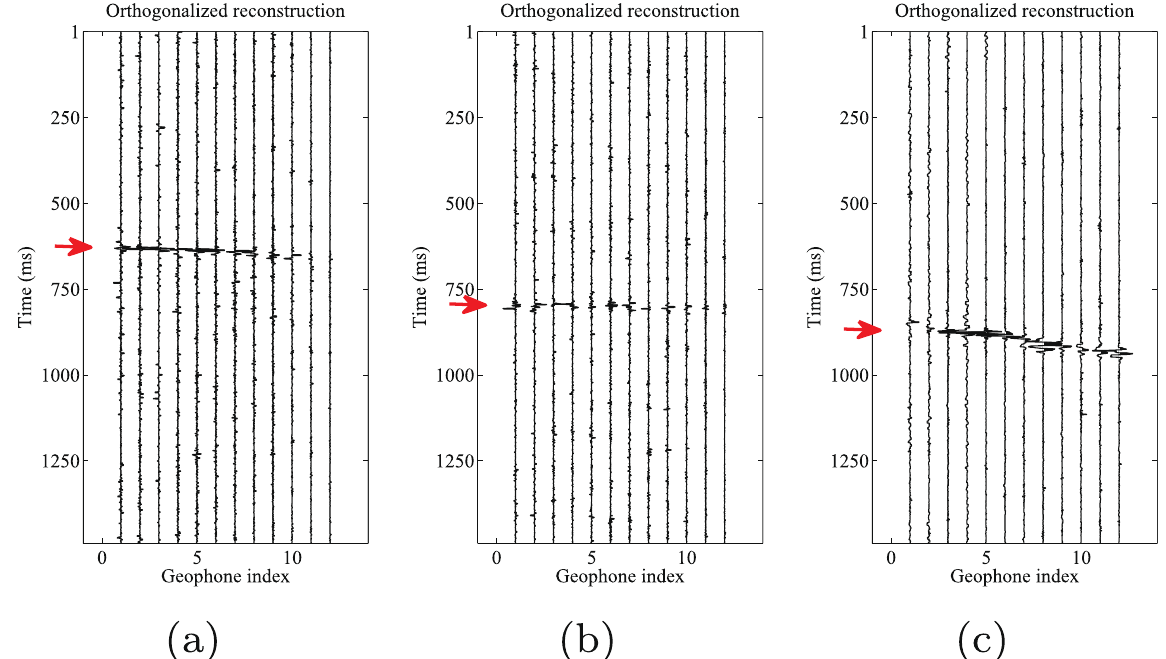
Figure 9. Orthogonalized morphological reconstruction results of ( a ) horizontal components (H1) by 2nd–4th scales components, ( b ) horizontal components (H2) by 2nd–4th scales components, and ( c ) vertical component (V) by 2nd–5th scales